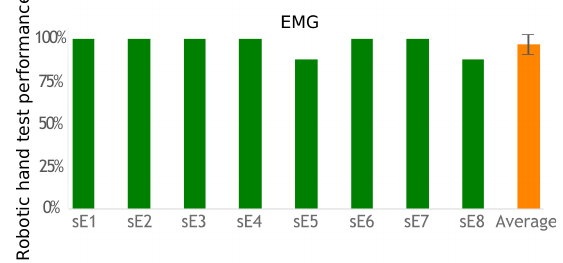
Figure 6. Performance results with the EMG system.